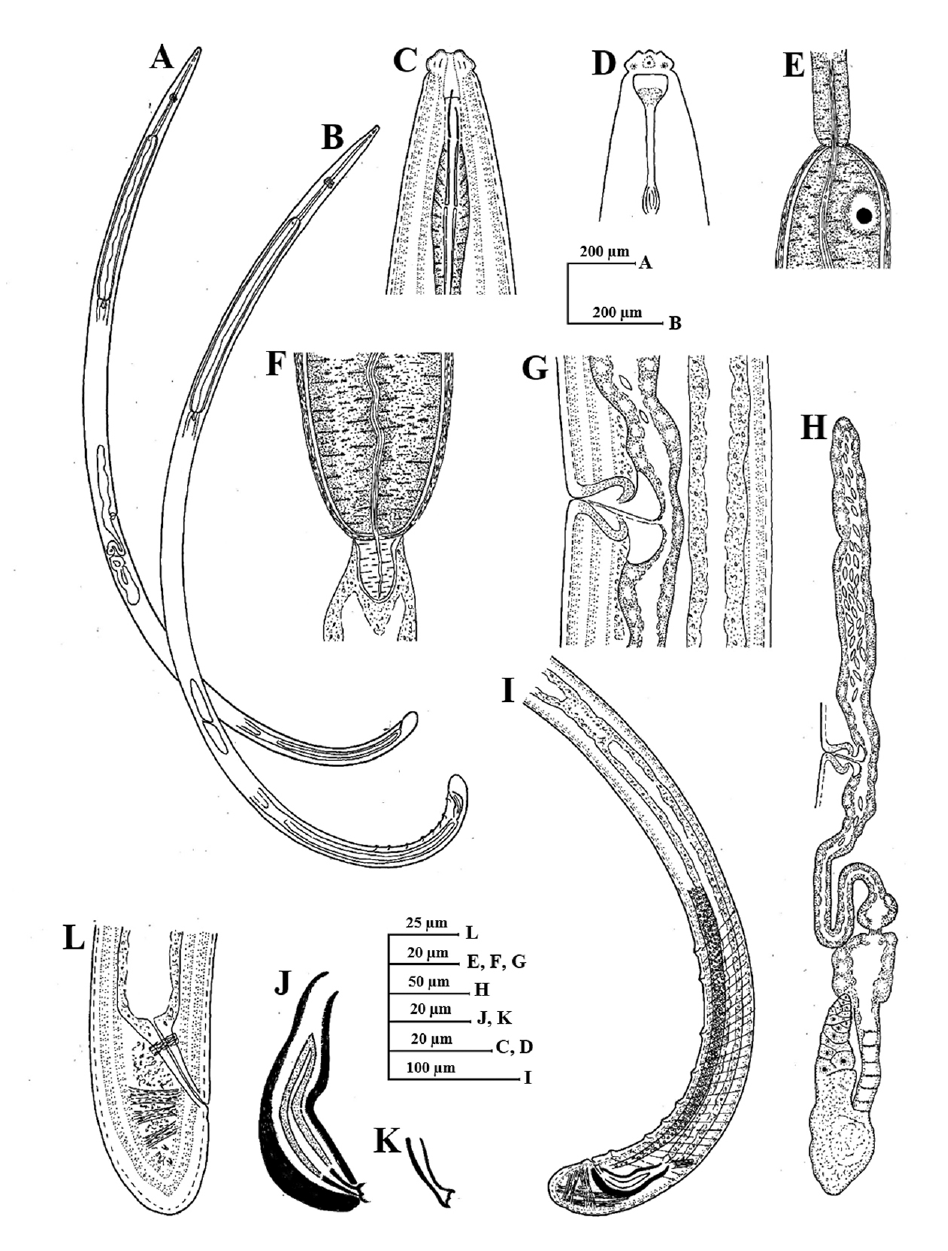
Fig. 11. Axonchium paracingulatum sp. nov. A , H . Holotype ♀ (AMU/ZD/ Axonchium paracingulatum sp. nov. /1). B , I – K . Paratype 1, ♂ (slide 2). C – G , L . Paratype 3, ♀ (slide 2). A . Entire female. B . Entire male. C . Anterior region. D . Anterior end showing amphid. E . Junction between anterior slender and posterior expanded part of pharynx. F . Cardia. G . Vulva. H . Female genital system. I . Male posterior region. J . Spicule. K . Lateral guiding piece. L . Female